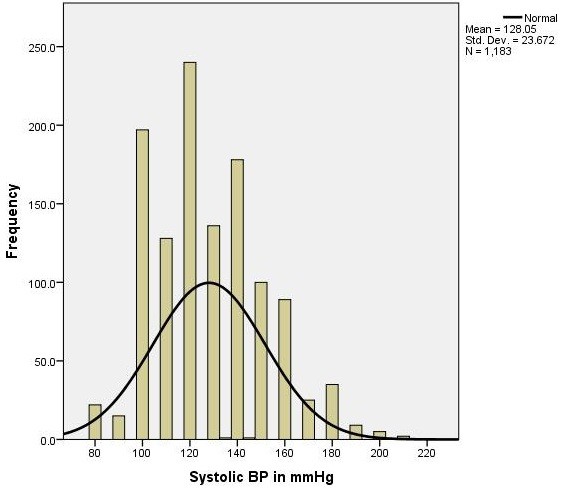
Graphic (histogram) distribution of systolic blood pressure of study participants (1183) aged ≥ 40 years in Kabul city, 2012.